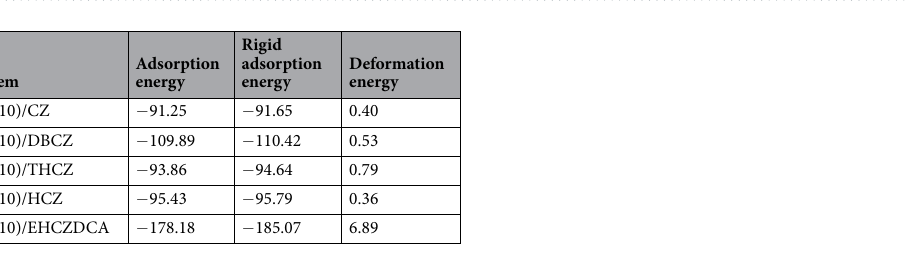
Table 8, is such that EHCZDCA > DBCZ > CZ > HCZ > THCZ, which is in partial agreement with the experi- mental inhibition efficiencies.